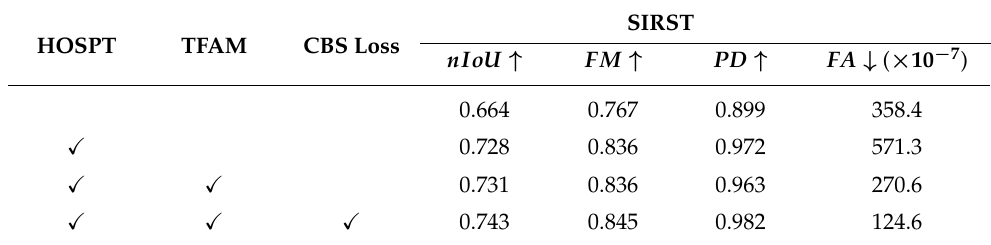
Table 4. The ablation study on the SIRST dataset.